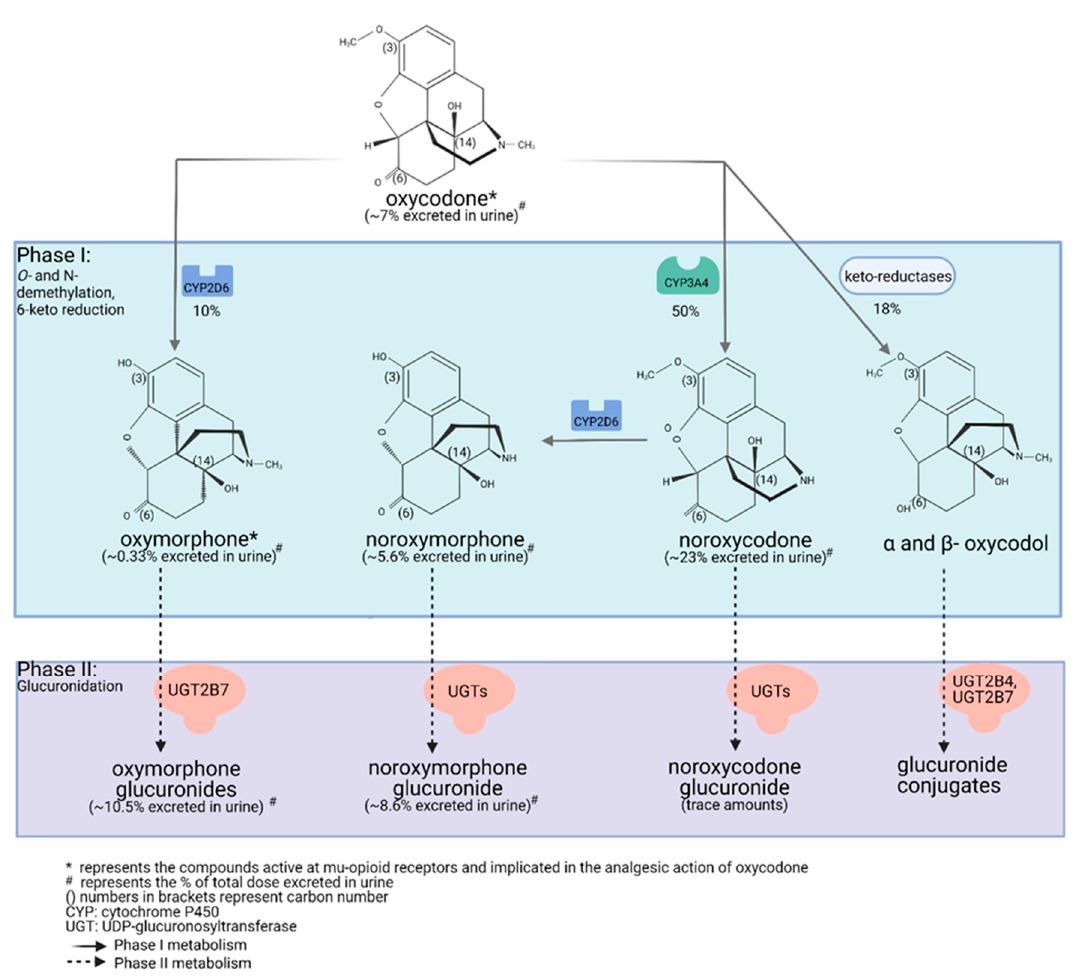
Figure 1. Detailed illustration of the elimination pathways of oxycodone. Created with Biorender.com (access date: 10 May